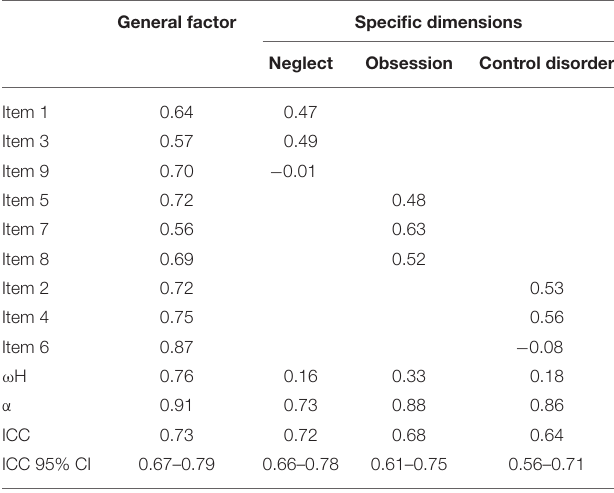
TABLE 3 | Standardized factor loadings and reliability indicators of the bifactor model with three specific dimensions of the